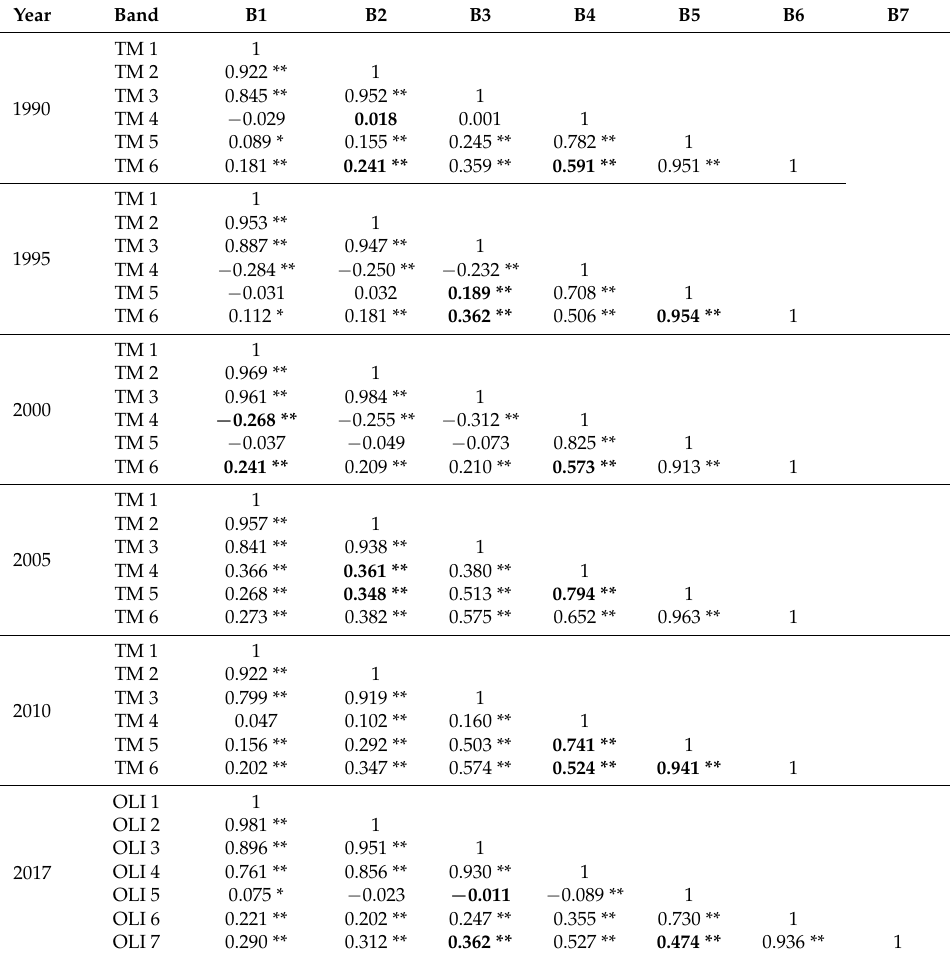
Table 2. Correlation matrices showing Pearson correlation coefficients between image features (i.e., spectral bands) for individual years. Values in bold face show the correlation between the bands used for the final RF